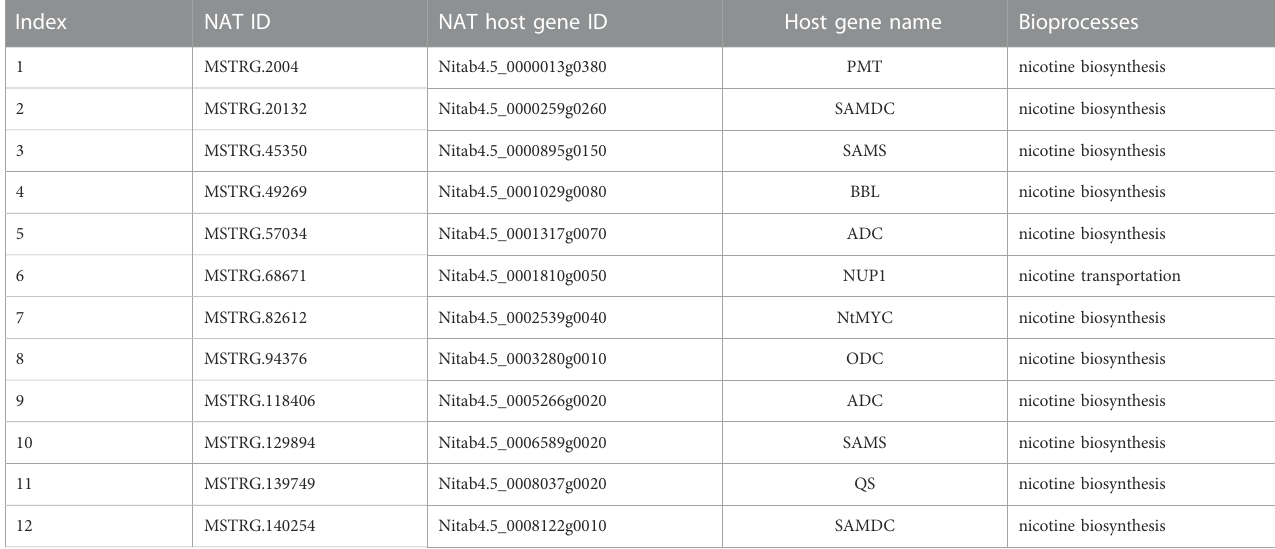
TABLE 2 The NATs are involved in nicotine biosynthesis or